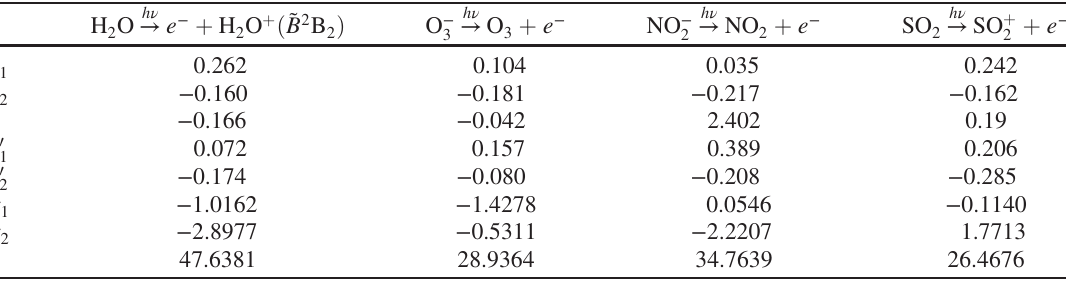
TABLE III. Dimensionless Doktorov parameters. All values are truncated to the precision that the operations are able to be implemented